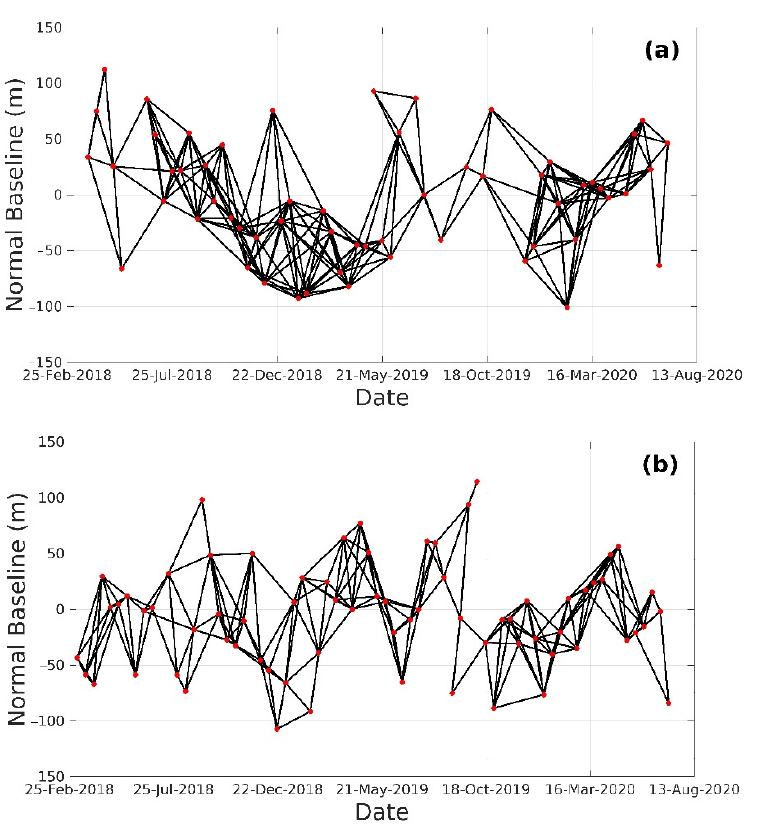
Figure 3. The interferometric combination of Small Baseline network for Sentinel-1A/B: ( a ) descend- ing track and ( b ) ascending track. The red circles and black lines represent SAR image acquisitions and interferometric pairs, respectively.